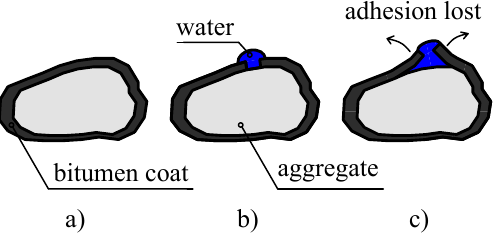
Figure 1. Aggregate coated by bitumen thin film, a) ideal state, b) real state, and c) stripping due to